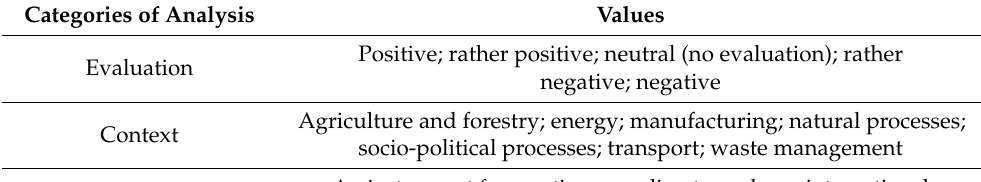
Table 1. Cont. Categories of